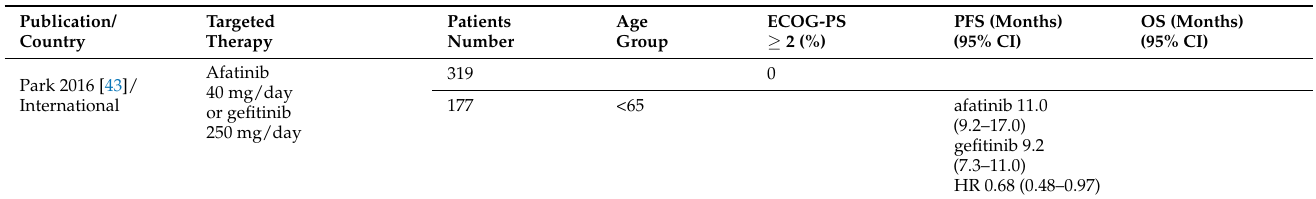
Table 2. Targeted therapy efficacy results in older patients in randomized or non-randomized trials (subgroup post-hoc